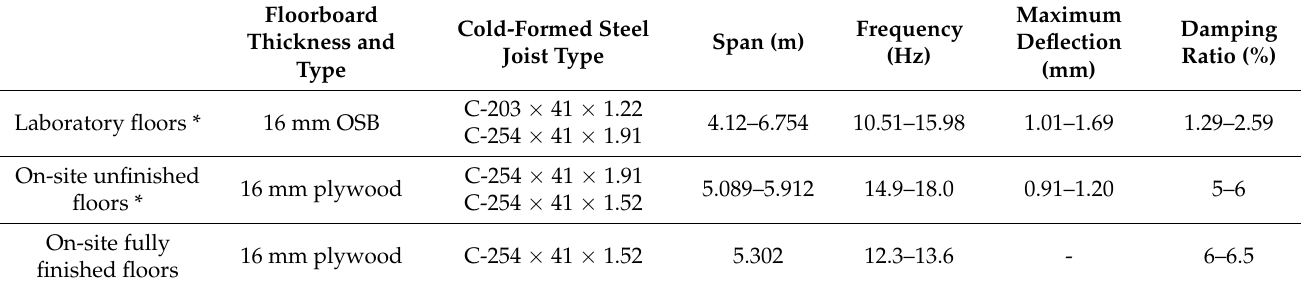
Table 1. Summary of laboratory and on-site results obtained from static and dynamic tests reported in Xu and Tangorra [34].